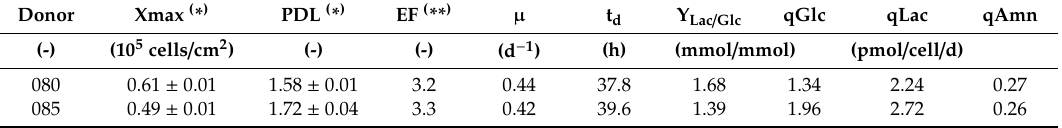
Table 4. Overview of the main growth-dependent parameters in the Corning spinner flasks.